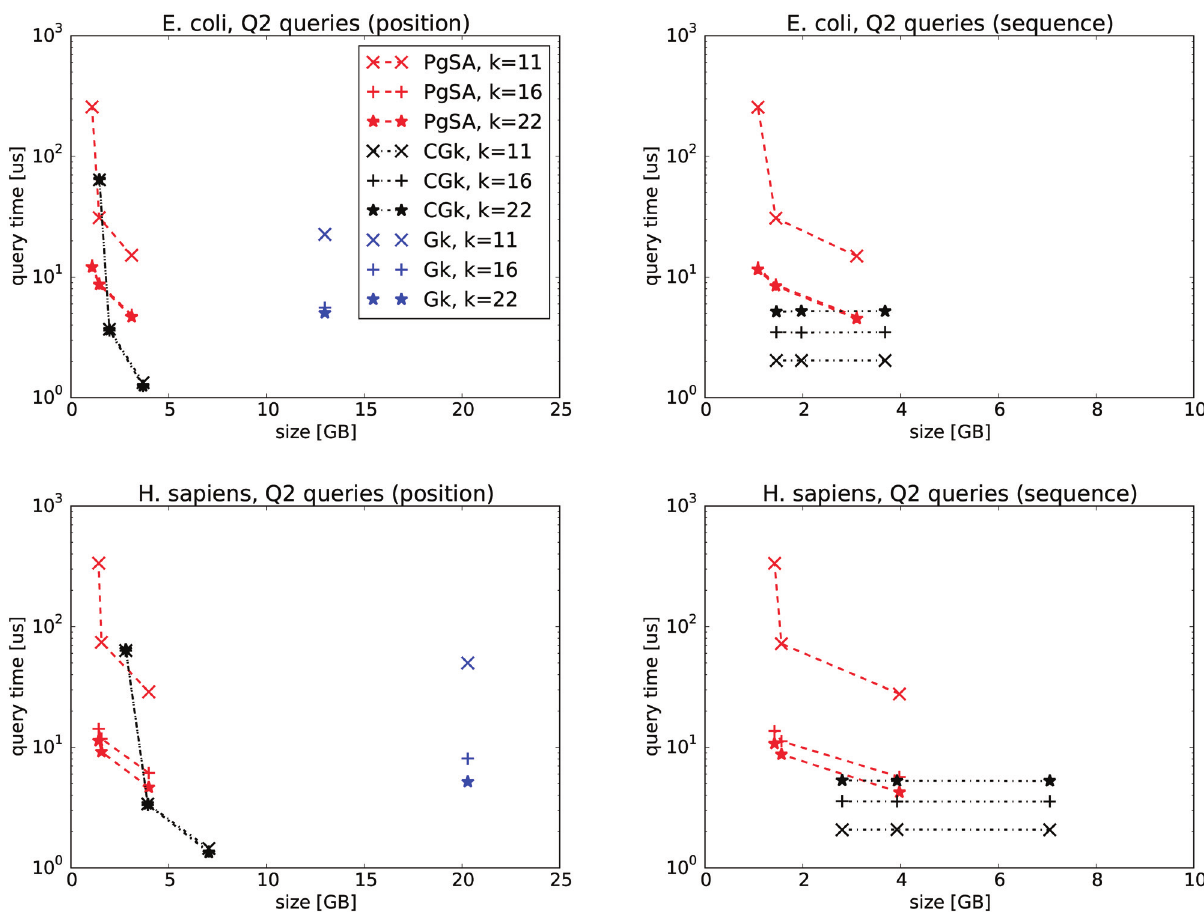
Fig 3. Q 2 query results on E. coli (top row) and H. sapiens (bottom row) datasets. The three points in PgSA series correspond to sparsity s = 6 for the leftmost point, s = 3 (E. coli) or s = 4 (H. sapiens) for the middle point and s = 1 for the rightmost point. The three points in CGk series correspond to sampling rates sr of 512, 25 and 6 (E. coli), and 512, 22 and 6 (H. sapiens), respectively. On the left figures the query is given as a position in the read list, while on the right ones as a string.